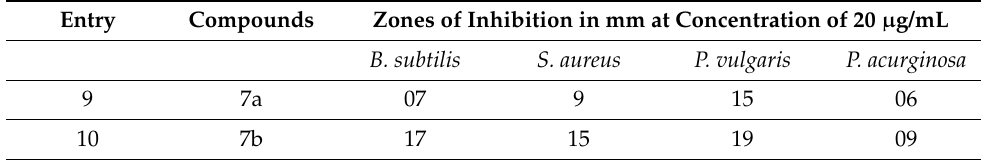
Table 5. Antibacterial activity data of spiro fused heterotricyclic compounds. Entry